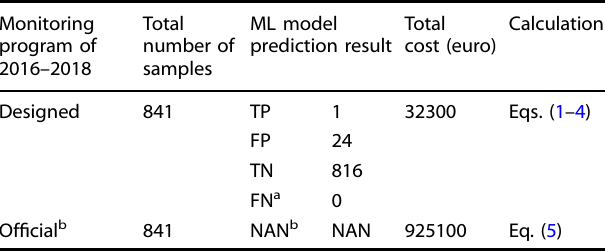
Table 4. The estimated cost of the of fi cial monitoring program and the designed monitoring program for AFB1 in feed in 2016 –